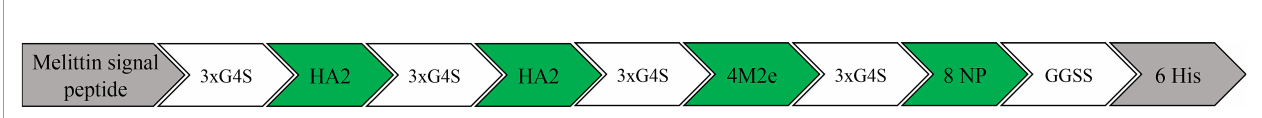
FIGURE 3 | Schematic representation of HMN structure. HMN: melittin signal peptide; two repeated copies of the hemagglutinin stem area amino acids 76-130 (2HA2); four repeated copies of the ectodomain of matrix protein M2 (4M2e); eight repeated copies of the nucleoprotein amino acids 55-69 (8NP); 6xHis tag epitope. 3xG4S,